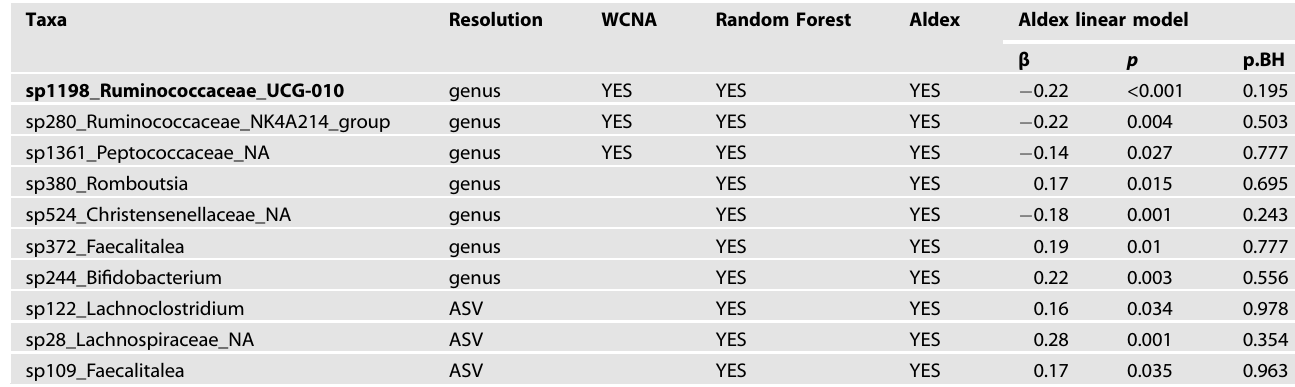
Table 2. Consensus mood-associated taxa (GAD-7